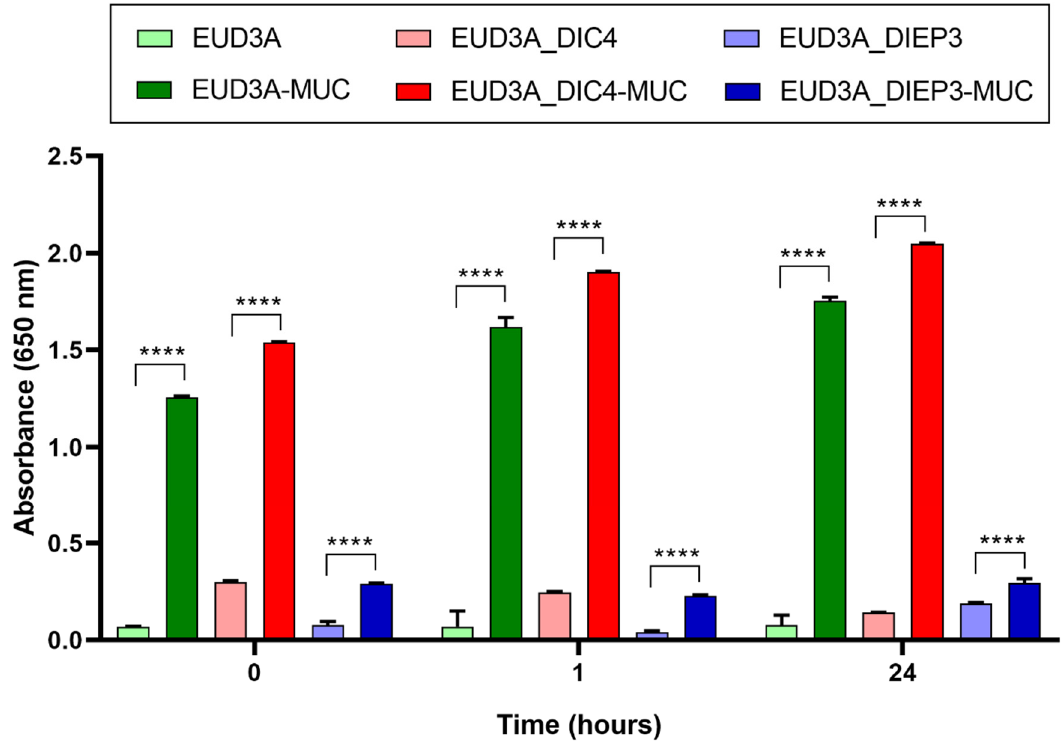
Figure 2. In vitro assessment of EUD3A, EUD3A_DIC4, EUD3A_DIEP3-mucin interactions by tur- bidimetric assay at 650 nm. Significance was set as **** p ≤